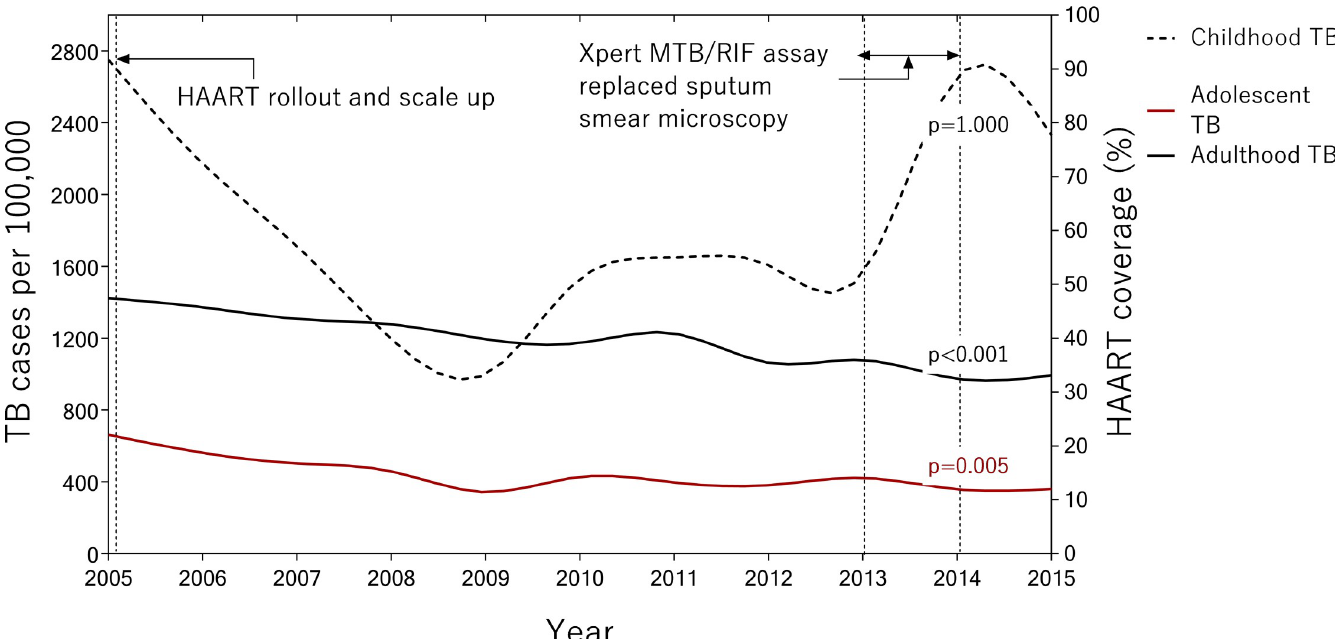
Fig 2. Comparison of adult and adolescent TB trends 2005–2015. Legend: TB = Tuberculosis disease (all TB). A = The period of rollout of Xpert MTB/RIF assay as a replacement for sputum smear microscopy. Between 2005–2015 all–TB rates declined by 15% from 2,750 to 2,331 per 100,000 among children; by 45% from 662 to 361 per 100,000 among adolescents; and by 30% from 1,423 to 994 per 100,000 among adults. P–value is for temporal trend between 2005–2015.